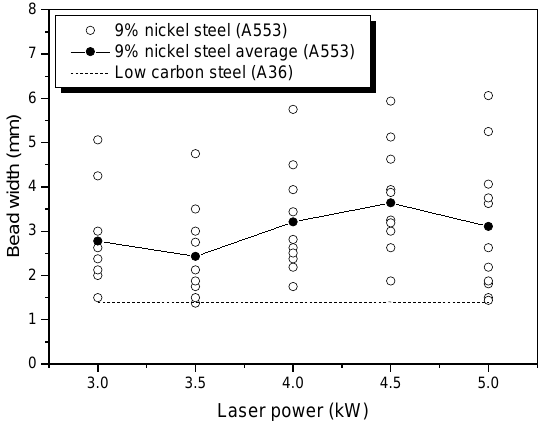
Figure 10. Width fluctuation of surface beads, according to laser power.